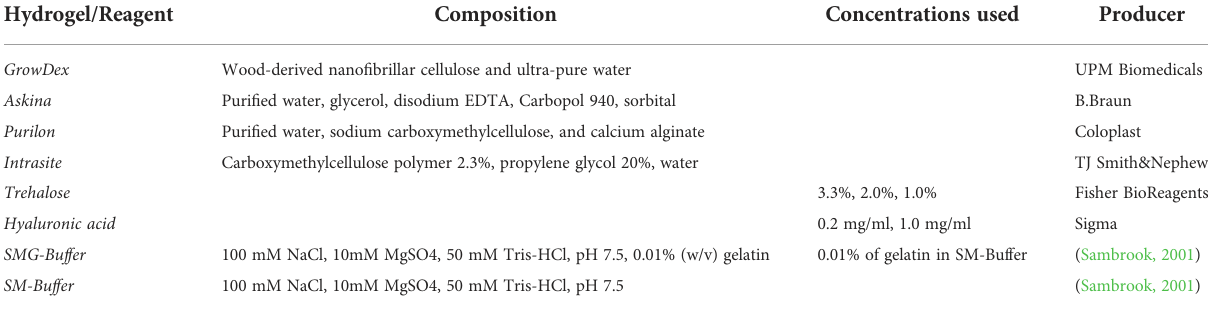
TABLE 3 Hydrogels and chemical stabilizers used in the